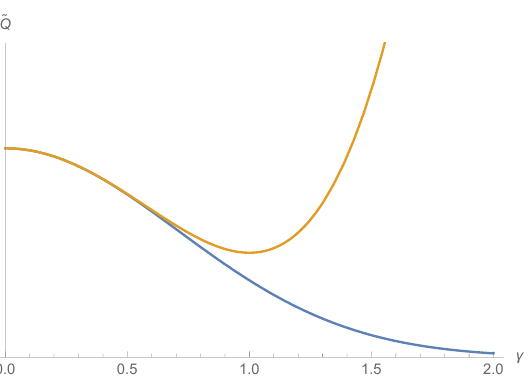
Figure 1: In blue is the di(cid:27)erence inequality, (50) , which displays exponential damp- ing in γ 2 . In orange is the absolute inequality, (115) , which increases (i.e. becomes weaker) for large masses. This plot was made using square-root Gaussian smearing func- tions, (8) , g ( x + , x − ) = 1 (cid:112) f (cid:112) G ( x + /δ + ) f (cid:112) G ( x − /δ − ) and choosing the boost parameter δ + δ − (cid:112) δ − /δ + to scale out the dependence on the smearing parameters as outlined in the e η = paragraph above equation (52)